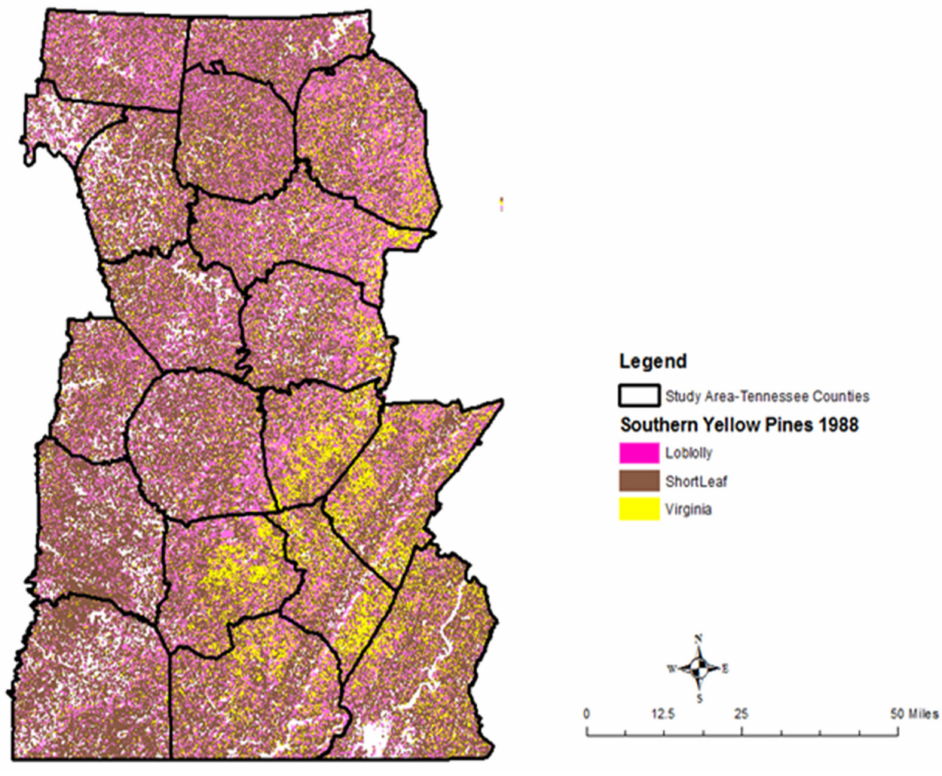
Figure 5. Classified southern yellow pines in December 1988. Table 1. Area covered by southern yellow pines in December 1988, November 1999 and February